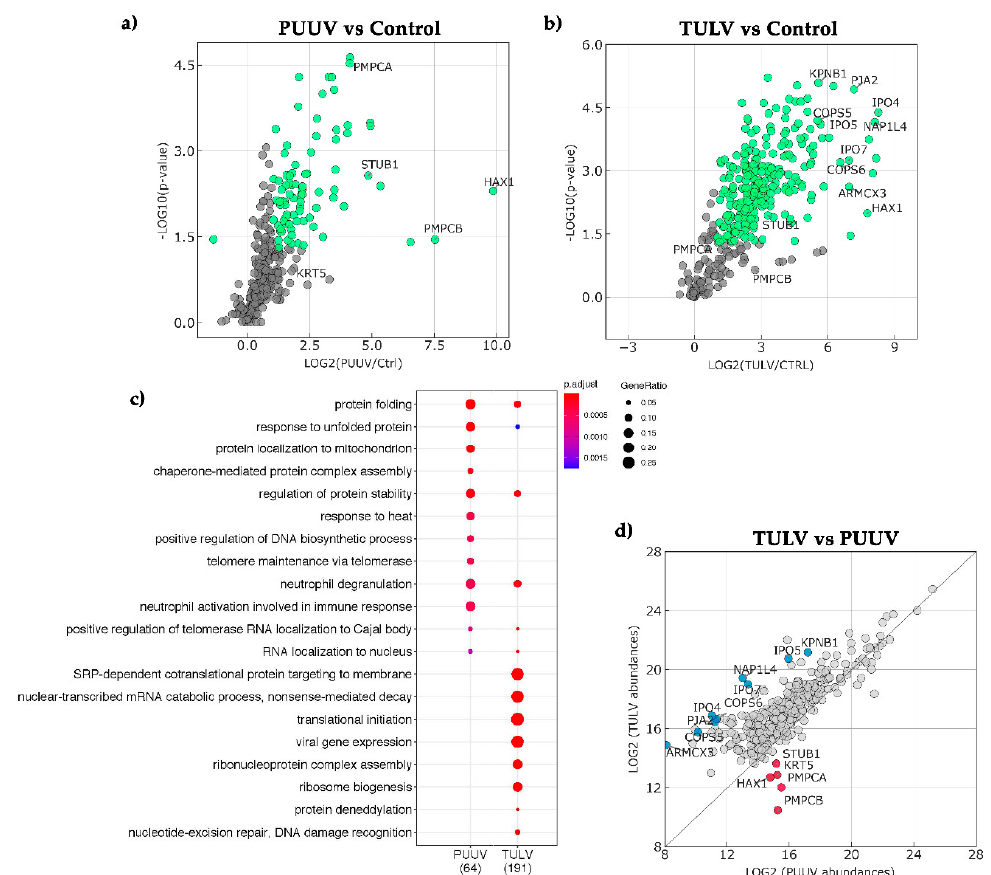
Figure 8. Proteins and their biological processes (BP) associated to pull down of PUUV and TULV NSs complexes. Mass spectrometry analysis was performed on biological triplicates of NSs PUUV and NSs TULV pull-down obtained from cell lysates of transfected HEK293T cells. The identification of human proteins associated to NSs was determined by comparison with the empty plasmid condition. Protein partners and associated BP, were sorted using filters retaining potential partners with p -value < 0.05, fold change > 2, more than one peptide found and a power > 0.8. In ( a ), volcano plot of differential pull-down assay of control (Ctrl) versus immobilized NSs of PUUV or in ( b ) of TULV are represented. The X -axis shows the LOG2 fold change and the Y -axis the logarithmic odds of a protein being differentially detected ( − LOG10( p -value)). Green points stand for sorted proteins, prior to logarithmic transformation, whereas grey points show proteins that do not satisfy fold change and p -value criteria. In ( c ), the dot plot visualized the top 20 enriched GO terms of BP that is associated to human proteins specific or common to PUUV and TULV NSs complexes. The number of proteins associated to the NSs proteins of PUUV and TULV, according to the defined criteria, are indicated below the panel. The color of the dots represents the p -value adjusted by Benjamini-Hochberg correction for each enriched GO term identified by Fisher’s exact test using enrichGO function in R package clusterProfiler, and the size of the dot represents the number of genes enriched in the total gene set. In ( d ), scatter plot of differential pull-down assay shows the LOG2 of protein abundances associated with immobilized TULV NSs (Y-axis) versus immobilized PUUV NSs (X-axis). All plotted values correspond to protein identification with at least 2 unique peptides. Values close to the dotted line correspond to proteins found in similar abundance in the two conditions and the more abundant proteins are indicated for PUUV in red and for TULV in blue. Although a smaller number of proteins were precipitated in complex with PUUV NSs as compared to TULV NSs (Figure 8b), at a ratio of 64 versus 191, two proteins associated to mitochondrial function, HAX-1, an antiapoptotic protein and subunit α and β of a mitochondrial processing peptidase involved in mitochondrial import were the most abundant in PUUV NSs protein complexes. STUB1, an E3 ubiquitin